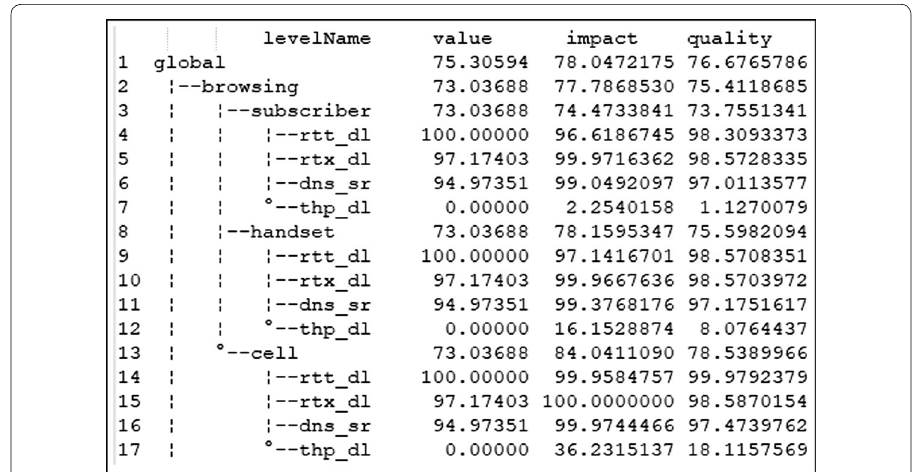
Fig. 5 SQM-tree result screenshot: This Figure shows a partial result of the SQM-tree. Each node of the tree holds three indicators which are the results of Algorithm 2. Those indicators are the value, the impact and the quality (which is an aggregation of the value and the impact). Those three metrics are in percentage and useful by simple sorting to determine the worst SQM-tree paths